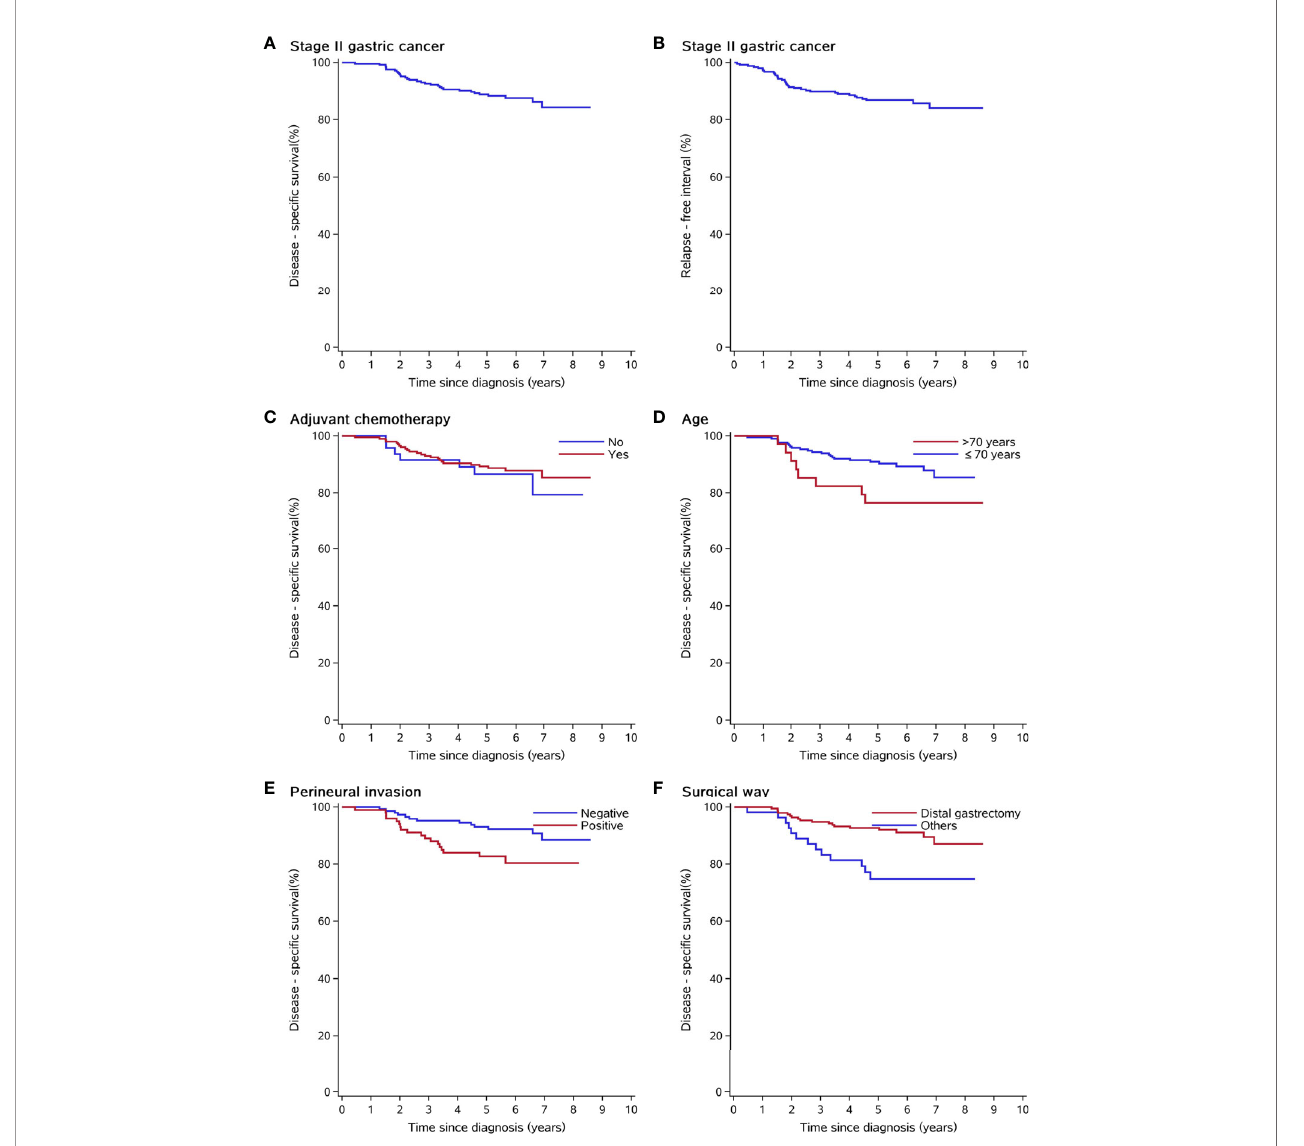
FIGURE 1 | Kaplan – Meier curves of clinical and pathological risk factors. (A) Disease-free survival of the whole study group. (B) Relapse-free interval of the whole study group. (C) Disease-free survival was not different among patients who underwent adjuvant chemotherapy or not. (D, E) Elderly patients and patients with positive nerve invasion had shorter disease-speci fi c survival. (F) Distal gastrectomy has better disease-speci fi c survival than other surgical approaches (transthoracic partial gastrectomy, proximal gastrectomy, and total